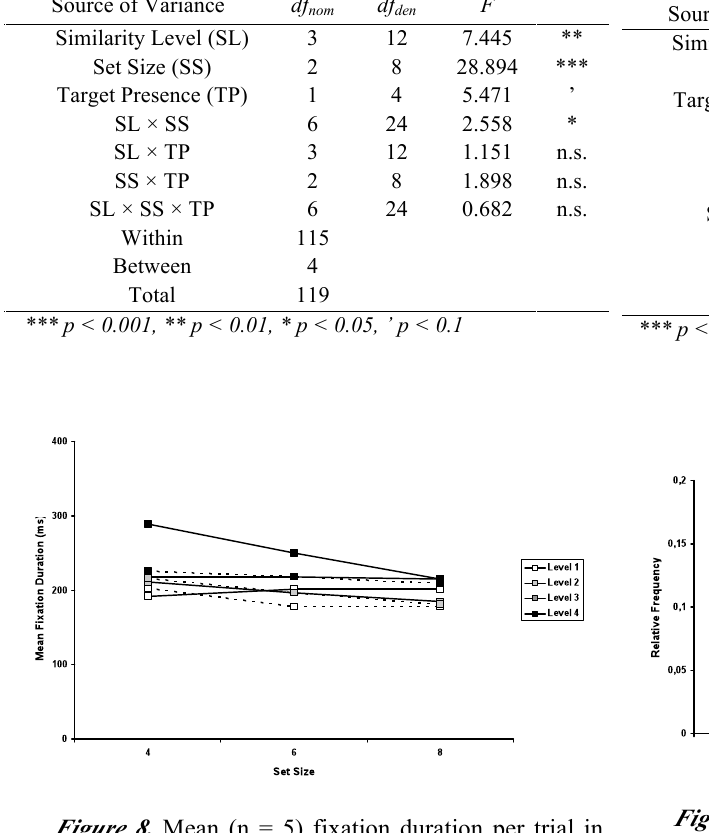
Figure 8. Mean (n = 5) fixation duration per trial in the four levels of similarity and for target-present trials and target-absent trials (dotted lines) with increasing item number.